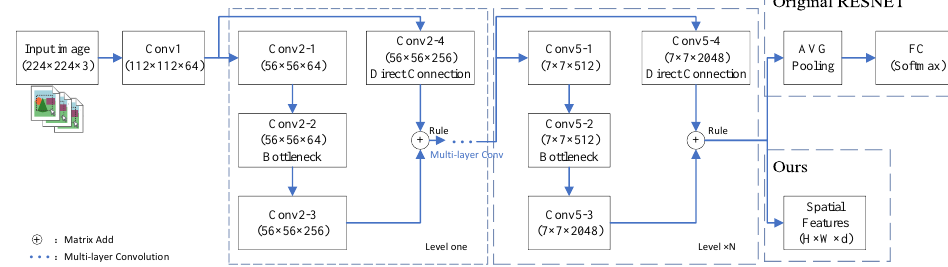
Figure 2. A brief framework diagram of